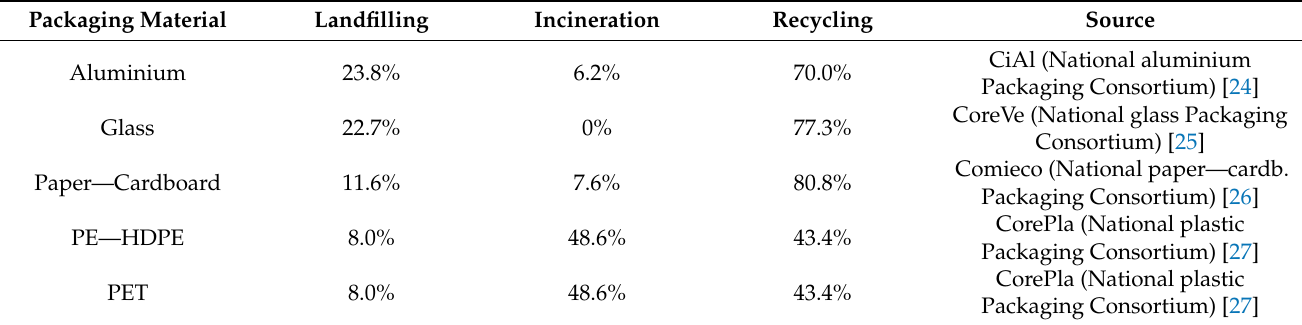
Table 5. Inventory data about the percentage composition of the disposal scenarios for each packaging material. Packaging